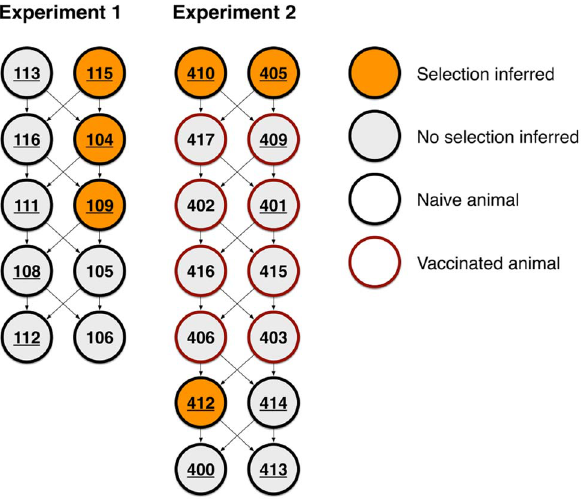
Figure 1. Evidence for selection was found in viruses from six animals across two experiments. Each pig is represented by a circle, numbered by index. Arrows between pigs represent potential transmission events. Pigs vaccinated before being infected are outlined in red; non-vaccinated pigs are outlined in black. Numbers of pigs for which data about the viral population was available for more than one time-point are underlined. Pigs in which selection was identified are highlighted in